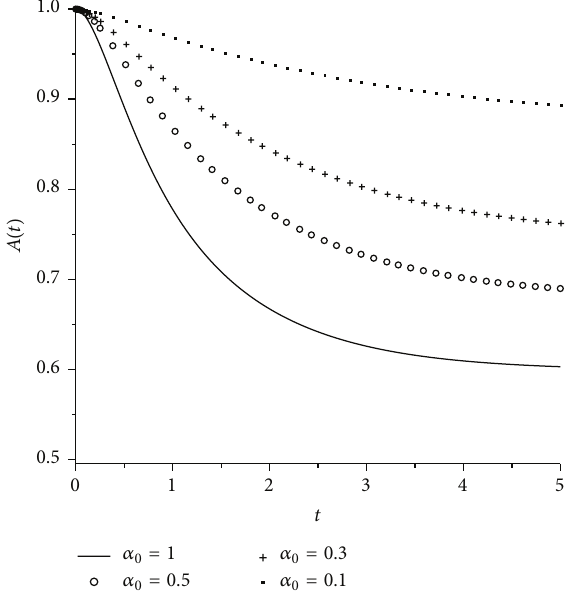
Figure 5: Instantaneous availabilities of the system with warning device with different 𝛼 0 .